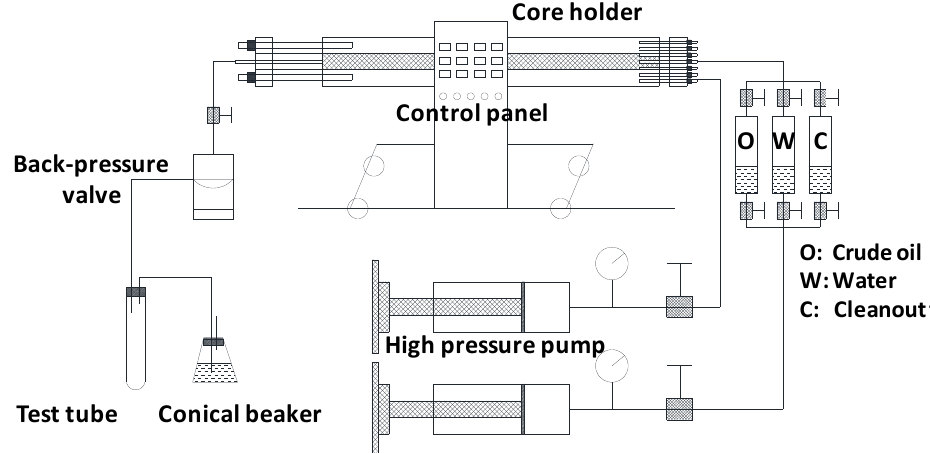
Figure 1. Diagram of the core displacement experiment.